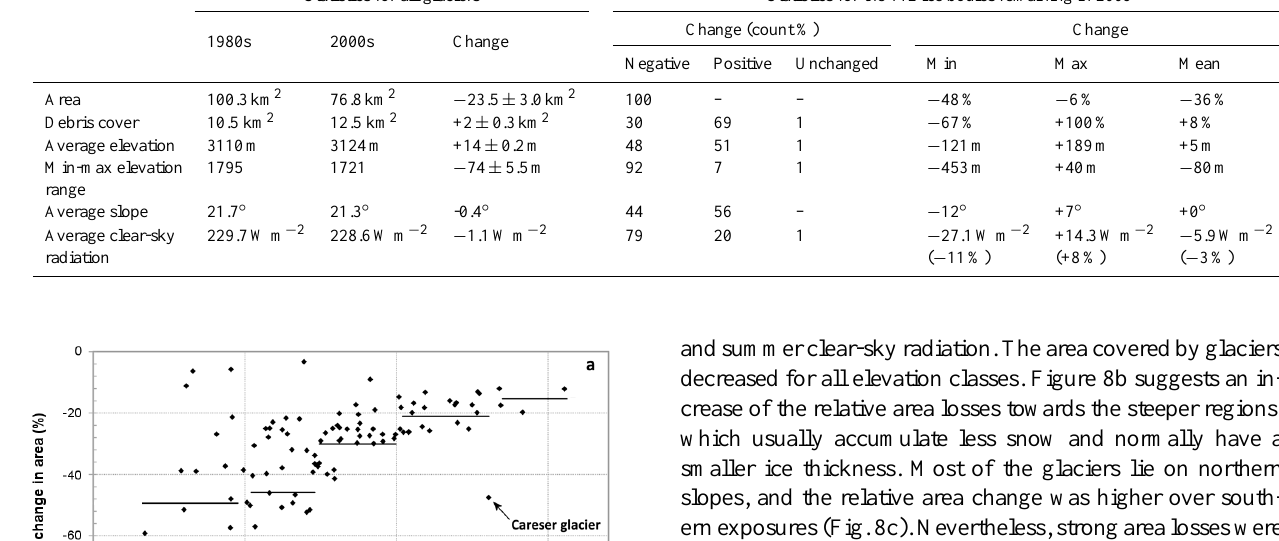
Table 3. Change of key parameters in the Ortles-Cevedale glacier system from the 1980s to the 2000s. Error bars for average elevation change (statistics for all glaciers) have been extrapolated by the geostatistical procedure described in Sect. 4.2. Statistics for all glaciers